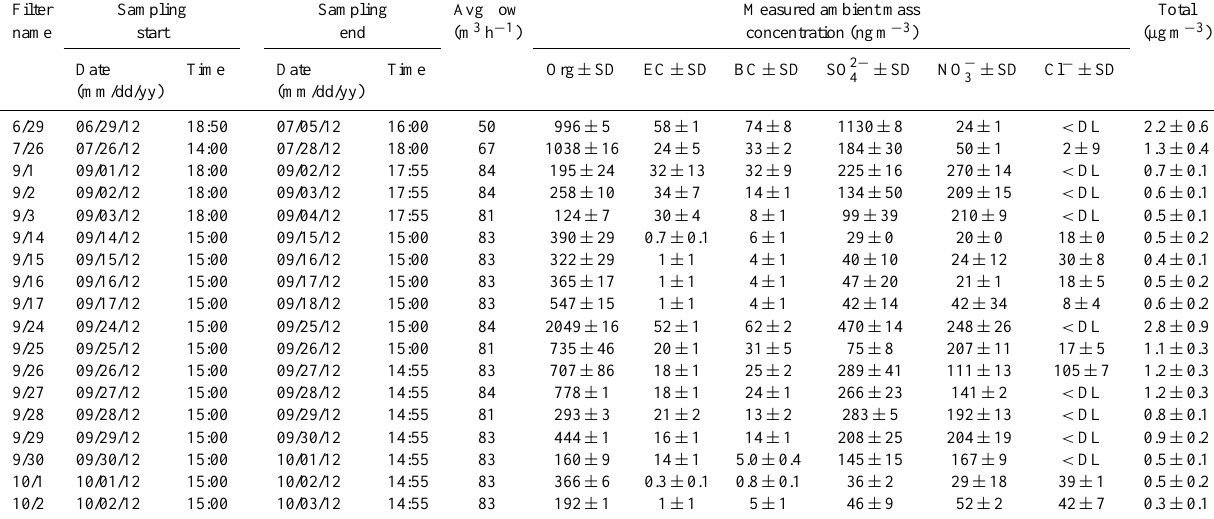
Table 1. Filters collected during the 2012 field campaign at the Pico Mountain Observatory. Collection times for all filter samples are 24h, except 6 / 29 (142h) and 7 / 26 (52h). Sampling times are given in local time (UTC). Average ambient concentrations of filter-collected PM 2 . 5 species are given, as well as BC mass concentrations measured with the aethalometer at seven wavelengths averaged to the filters collection periods. All measurements are given with their respective standard deviations (1 σ) . Note BC is not included in the calculated